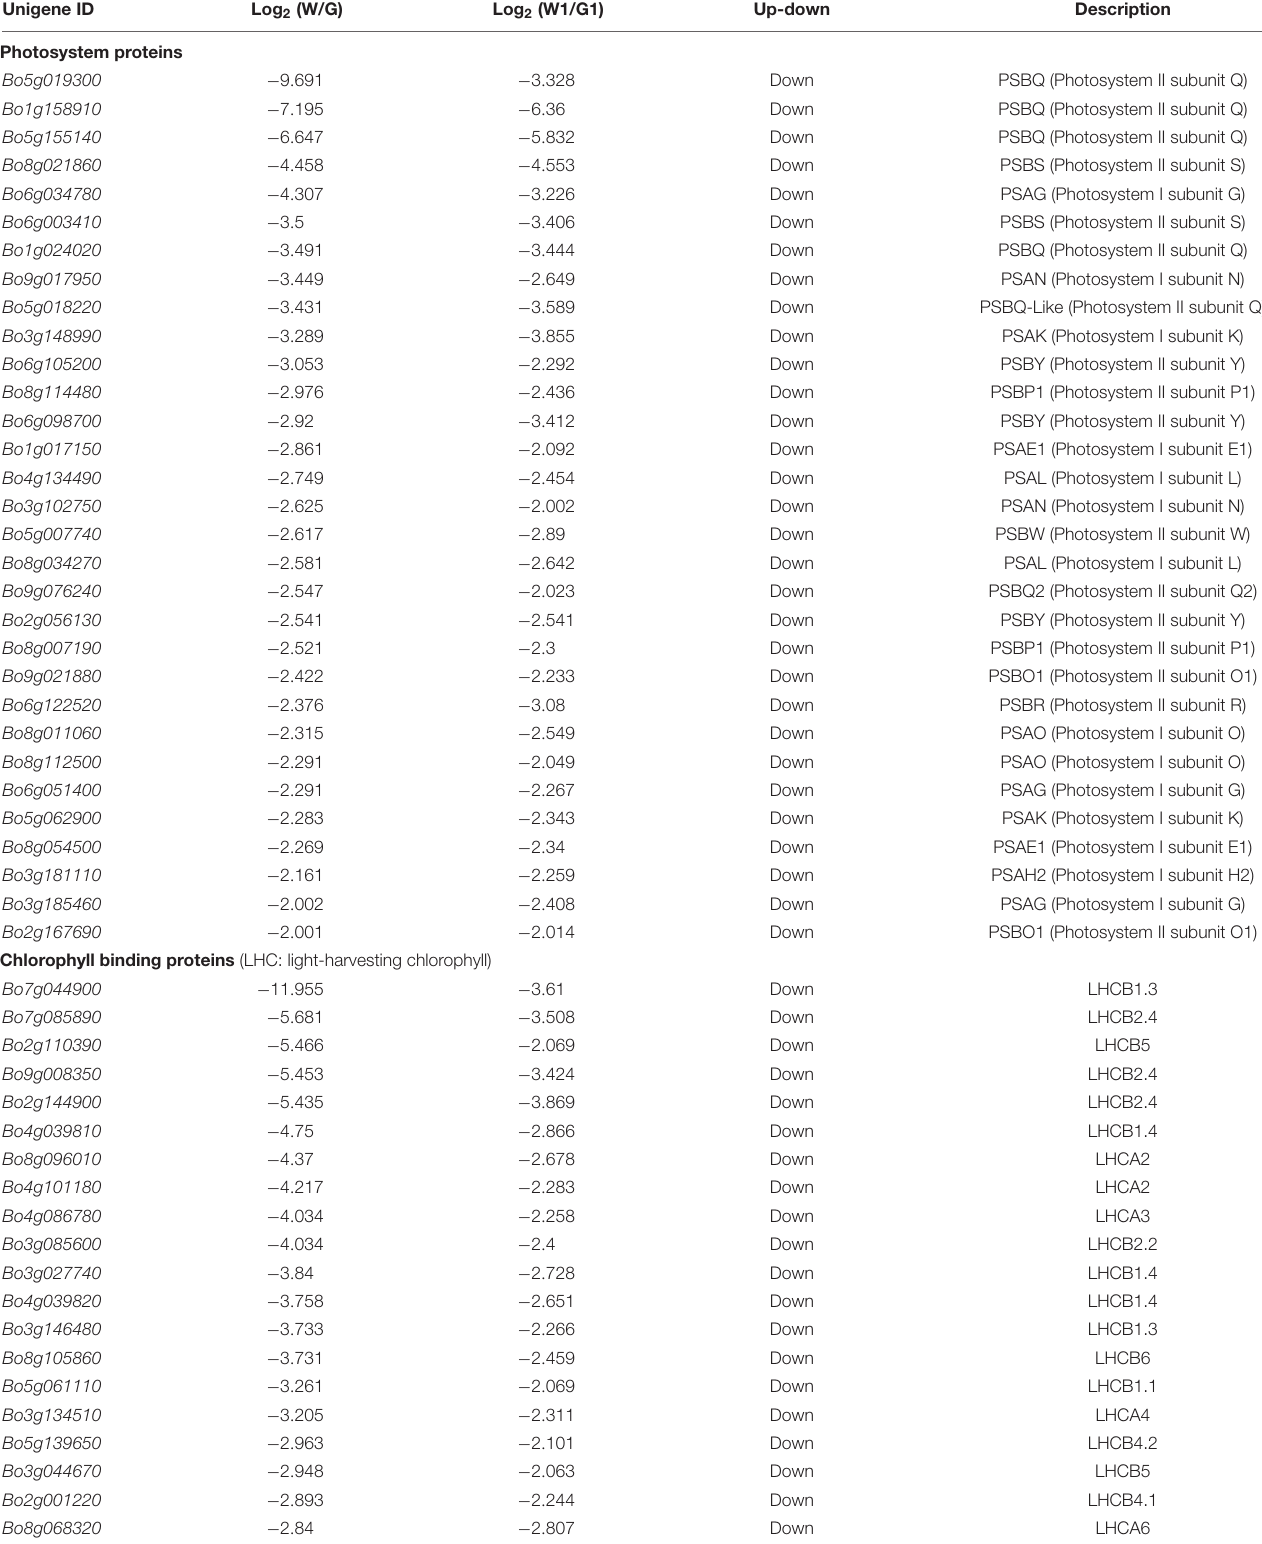
TABLE 2 | Genes encoding photosystem proteins, chlorophyll binding proteins and others. Unigene ID Log 2 (W/G) Log 2 (W1/G1)